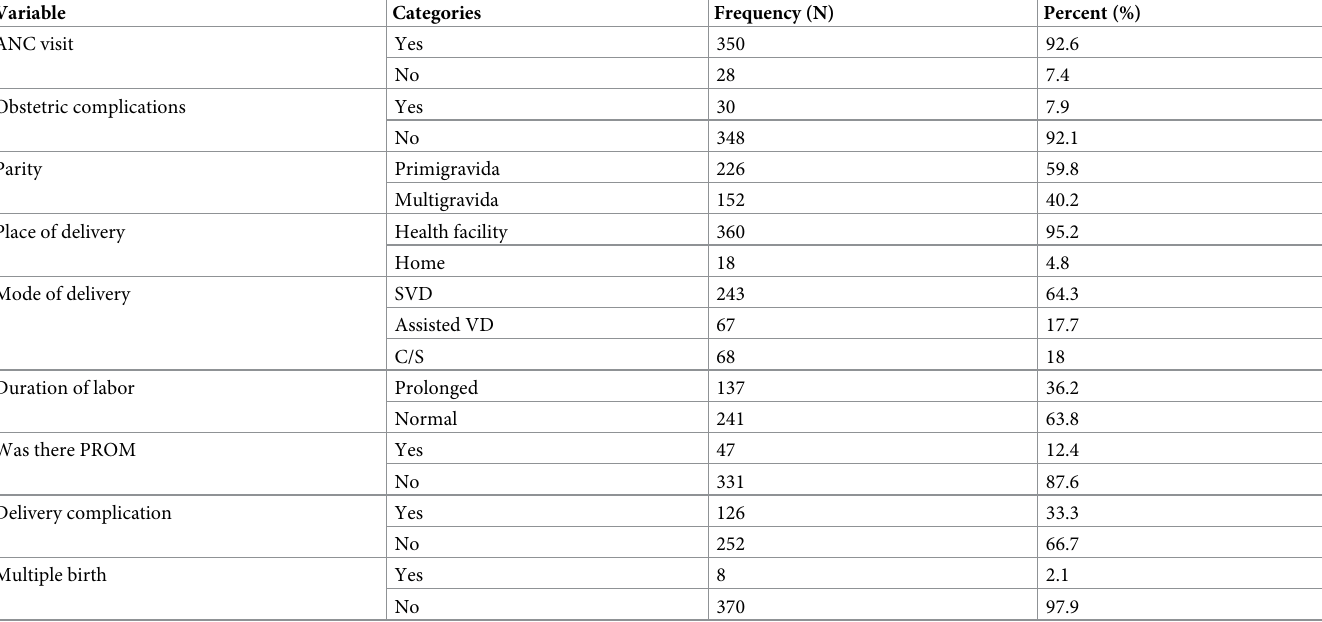
Table 2. Reproductive health related characteristics of the mothers in DCSH, Amhara region, Northeast Ethiopia (N =